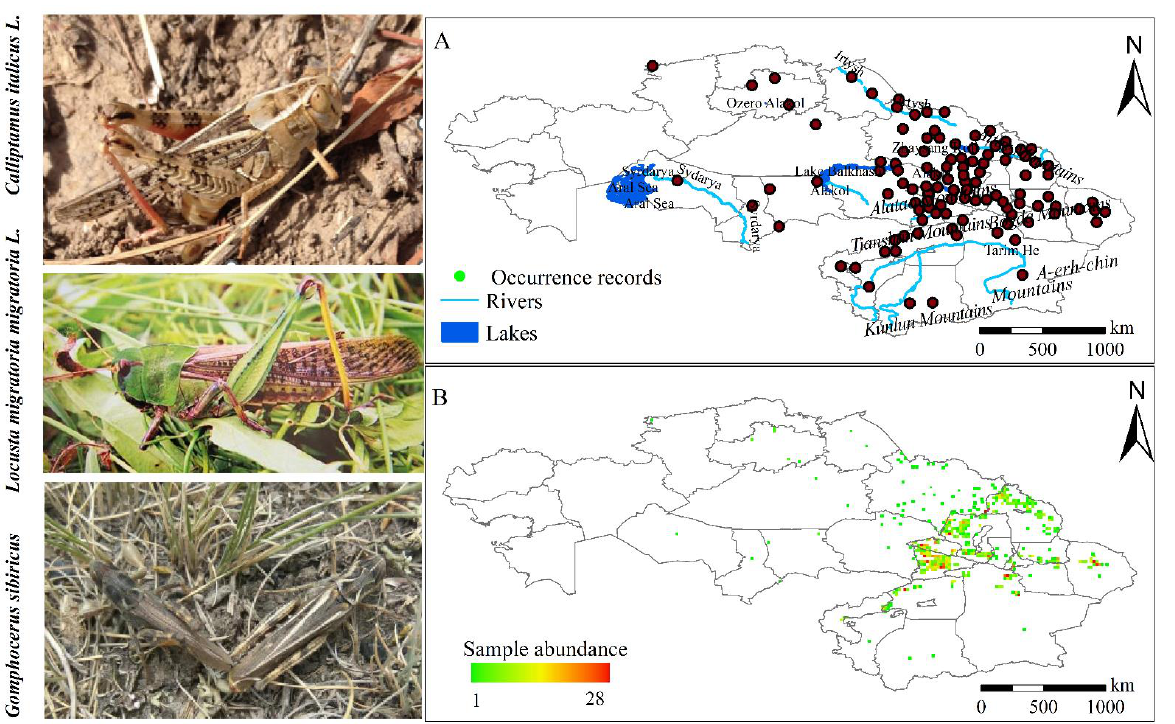
Figure 1. ( A ) Screened sample records. ( B ) Spatial richness of typical locust samples when unscreened.